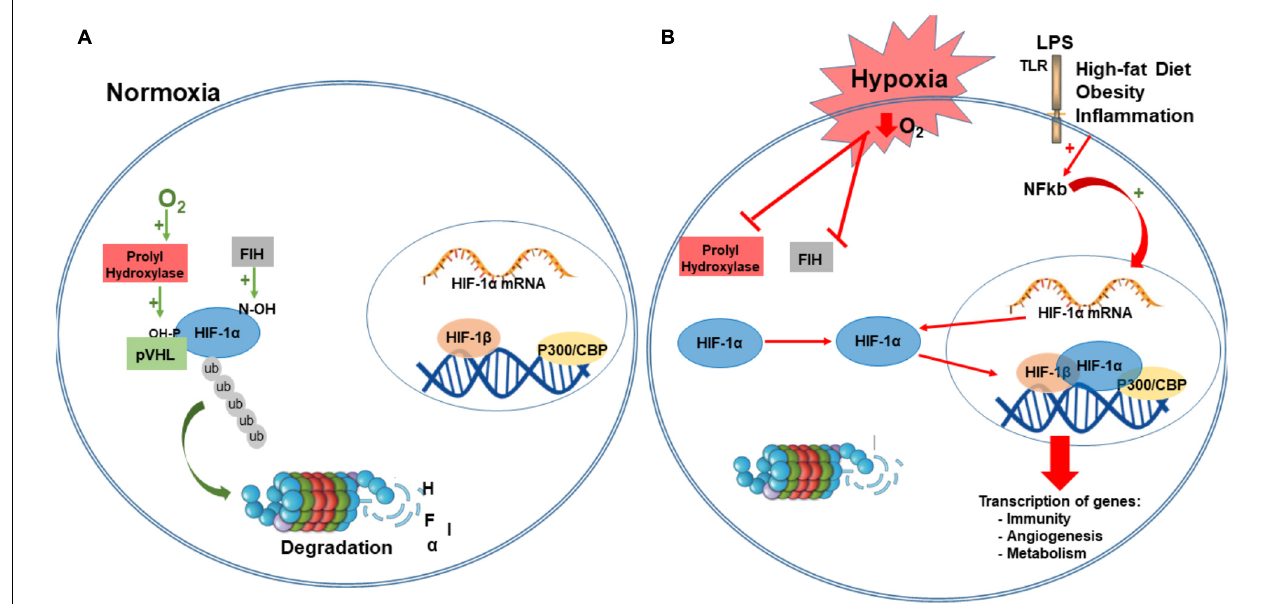
FIGURE 2 | Hypoxia-inducible factor-1 regulation. Under normoxia, HIF-1 α is hydroxylated on proline residues 402 and 564 by prolyl hydroxylases (PHD). This hydroxylation is a target for von Hippel-Lindau protein (VHL) binding, a E3 ligase that targets HIF-1 α for ubiquitination and proteasomal degradation. Factor inhibiting HIF-1 (FIH-1) hydroxylated an asparagine residue (803) that blocks the binding of the coactivator p300/CBP (A) . Under hypoxia, PDH and FIH are inhibited and HIF-1 α is stabilized to dimerize with HIF-1 β , and binds to target genes at the DNA, recruits p300, and activates transcription of several genes involved in immunity, angiogenesis, metabolism, survival, and proliferation. Immune and inflammatory stimuli can also regulate the HIF pathway, primarily via activation of Toll-like receptors (TRL) and NF-kB activation. NF-Kb is translocated to the nucleus where it regulates the expression of HIF- α mRNA (B) . CBP/p300, Creb Binding Protein/p300; LPS, lipopolysaccharide; PHD, prolyl hydroxylases; VHL, von Hippel-Lindau protein; FIH-1, factor inhibiting HIF-1; P-OH, hydroxylation in proline residues; N-OH, hydroxylation in asparaginyl residues; TLR-4, Toll-like receptors; ub, ubiquitin; NF-kB, nuclear factor kappa-light-chain-enhancer of activated B